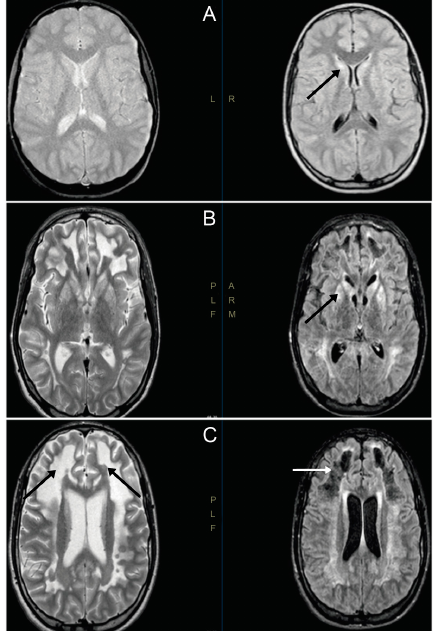
Figure 1. Magnetic resonance images of V-4’s brain. ( A ) Cranial magnetic resonance images (MRIs)